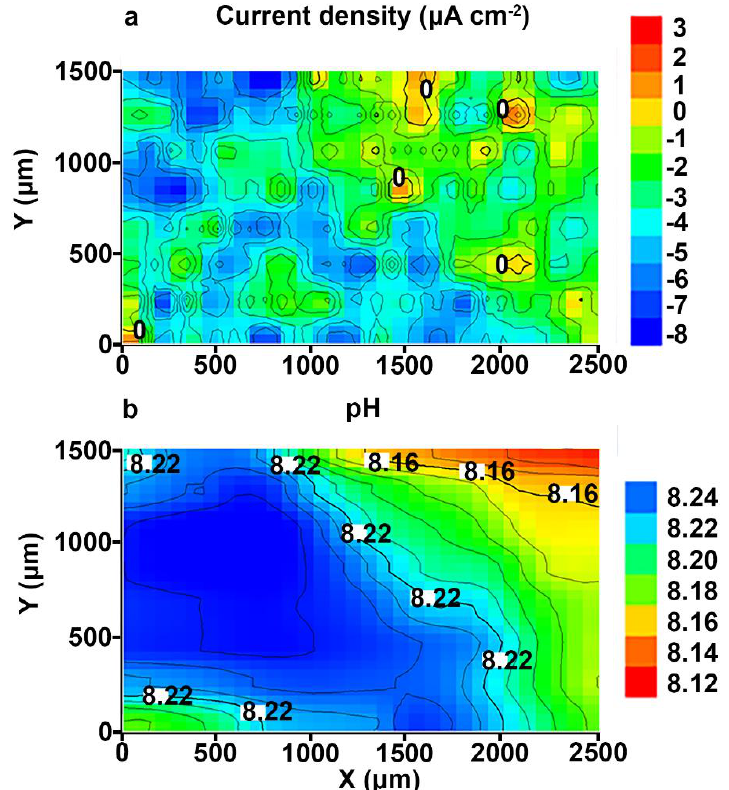
Figure 8. The ( a ) SVET and ( b ) SIET diagrams of the current density and pH distribution on